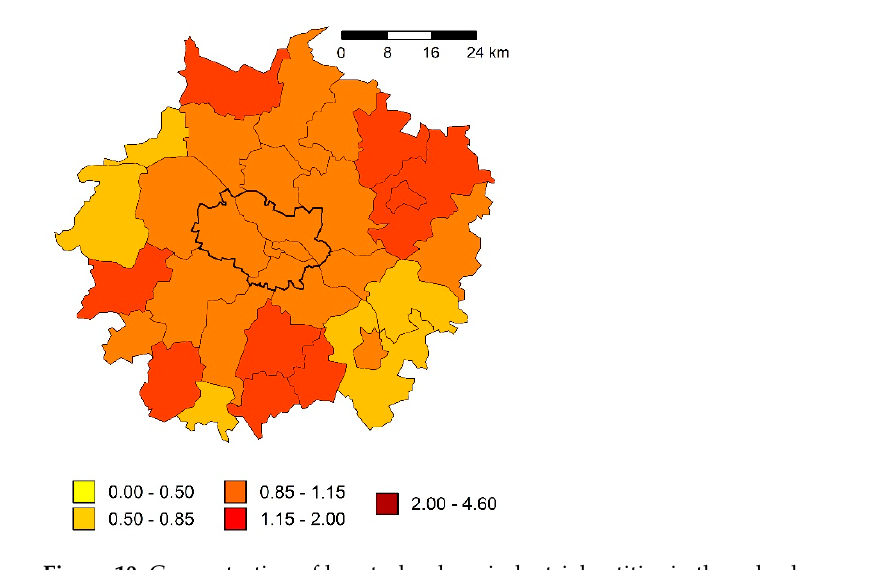
Figure 10. Concentration of low-technology industrial entities in the suburban area of Wroc ł aw in 2016 (sourced by authors). 2016 (sourced by